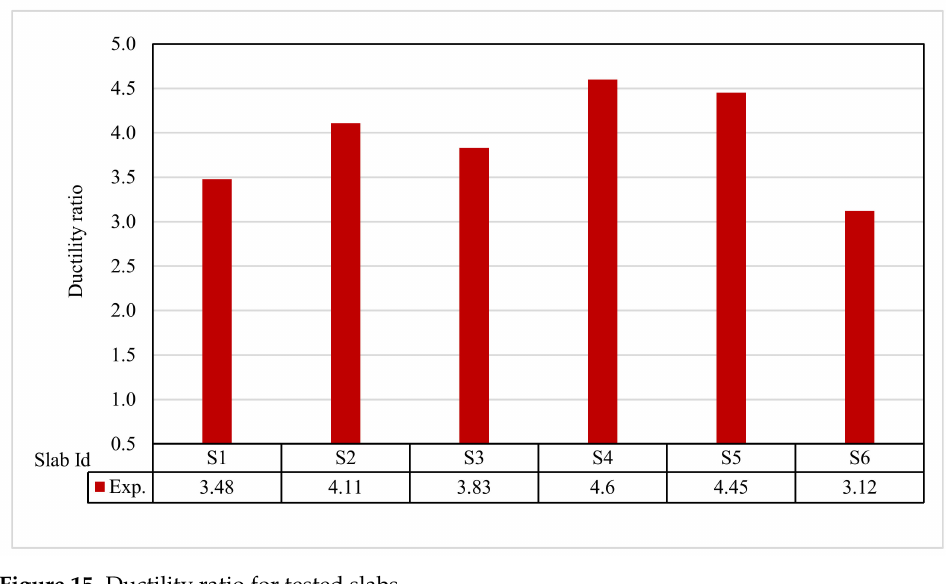
Figure 15. Ductility ratio for tested slabs.